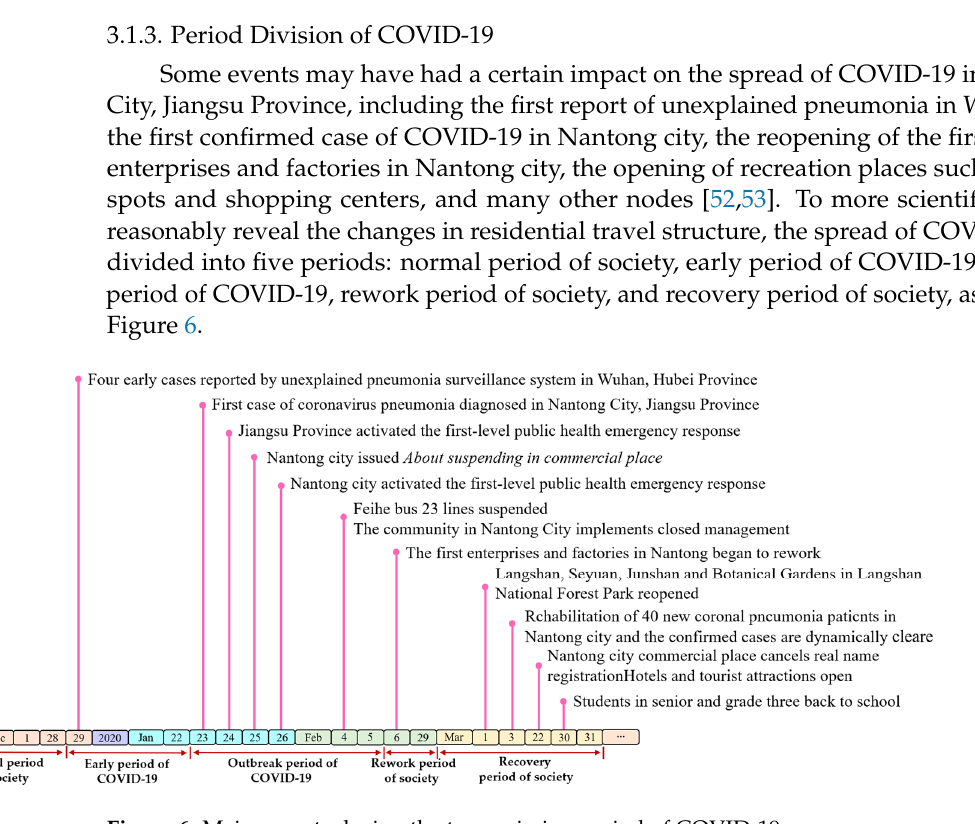
Figure 6. Major events during the transmission period of COVID-19.